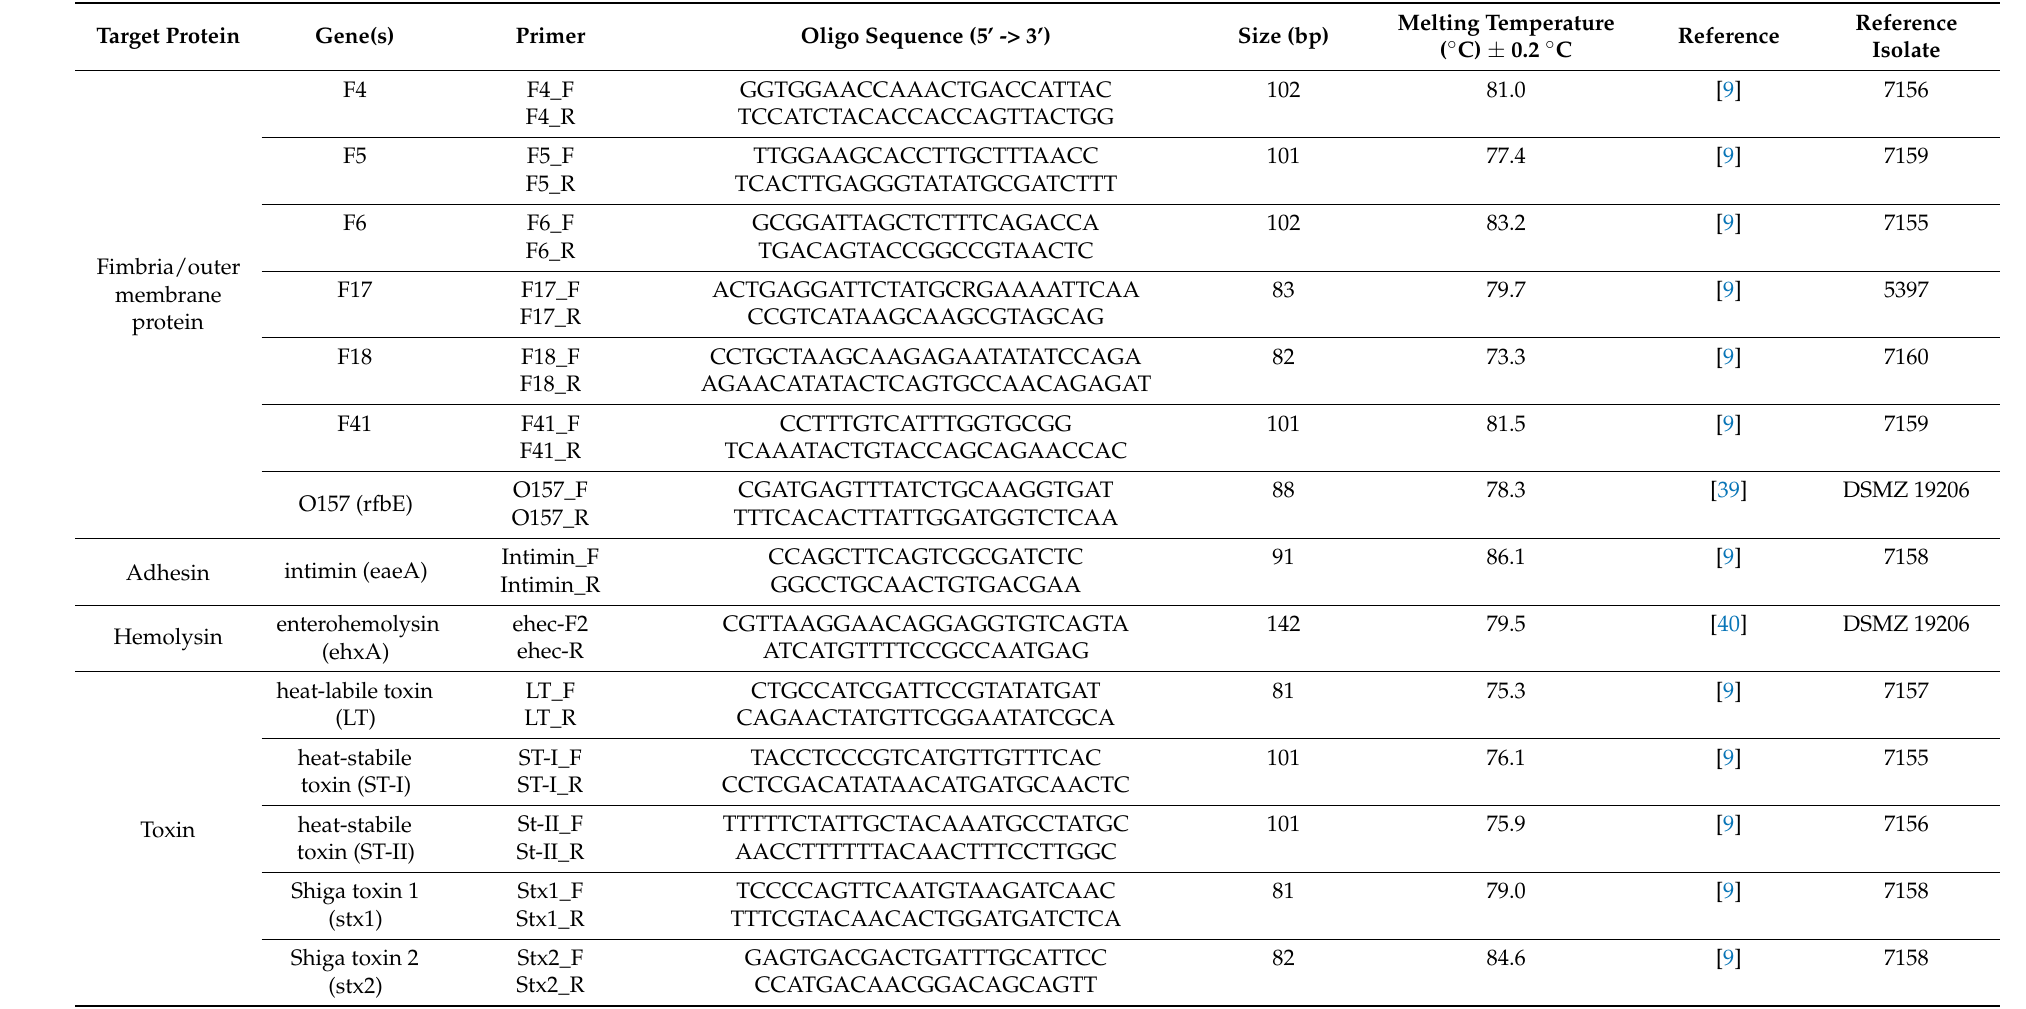
Table 4. Targets and primers for the molecular characterization of E. coli isolated from